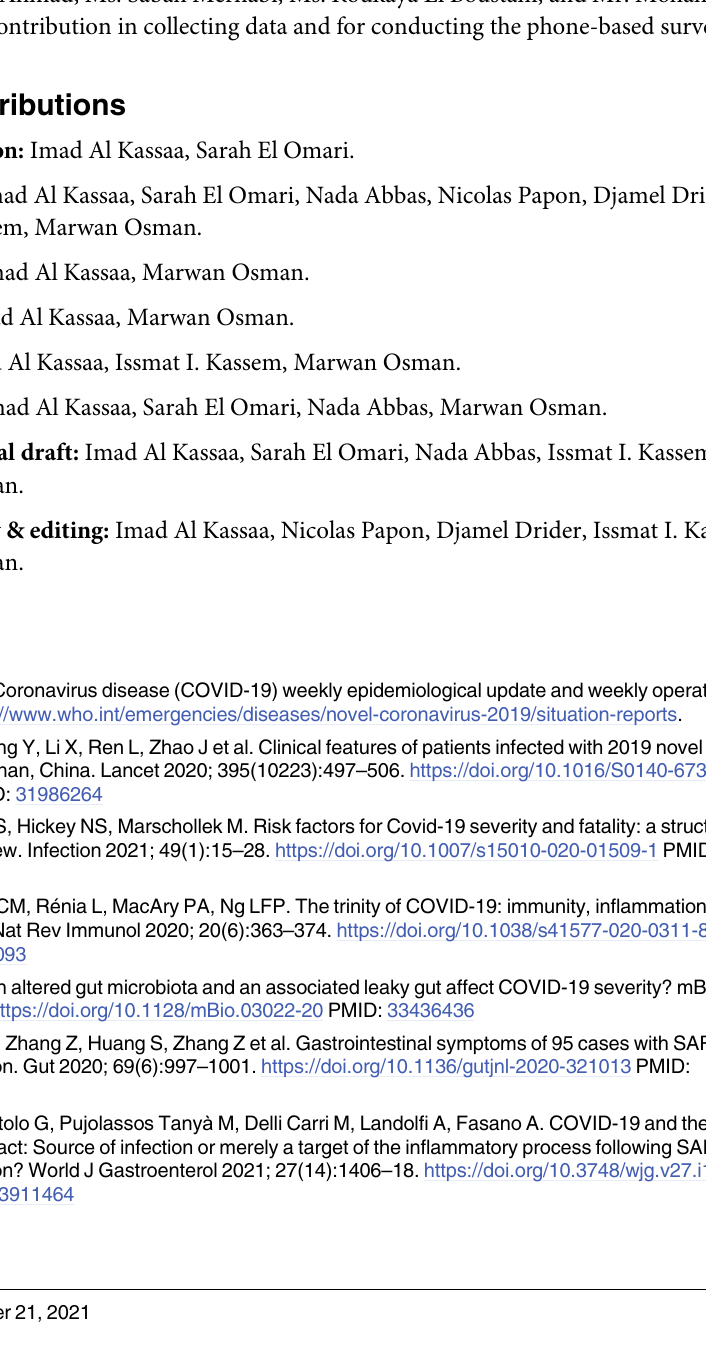
S1 Table. Detailed description of medical history information. S2 Table. Detailed description of healthy/unhealthy food intake and residual